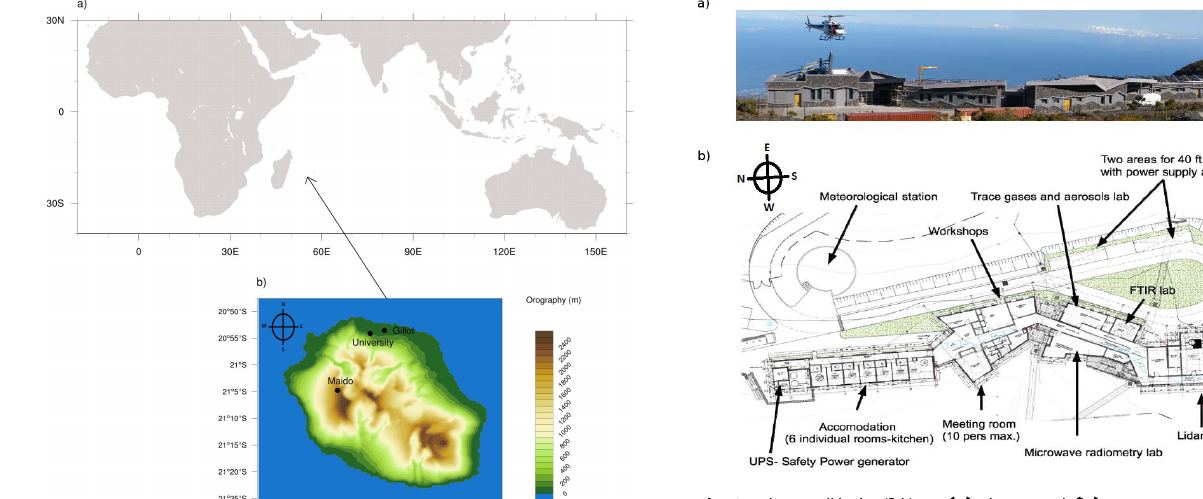
Fig. 2. The Maïdo building: (a) photo and (b)